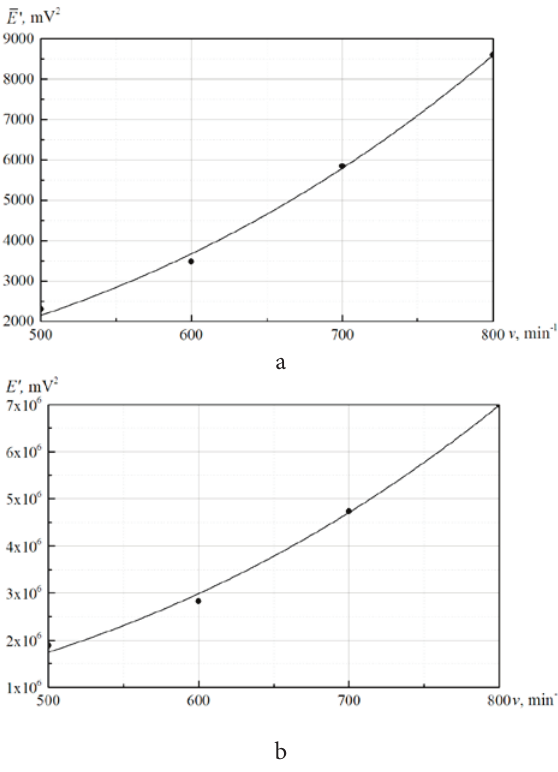
Fig. 6. Diagrams of accumulated average energy ' E ( a ) and accumulated total energy E' ( b ) of a resulting acoustic emission signal depending on the rotational speed of a friction pair v As the analysis of the data obtained shows, if speed v is equal to 500 min –1 , the values of the rates of accu- mulated average energy ' E and accumulated total en- ergy E' of acoustic emission signals that form will be taken as ' E = 2306.57 mV 2 and E' = 1.88 х 10 6 mV 2 . When value v is increased 1.2 times (to 600 min –1 ) the values ' E and E' increase, respectively, 1.505 and 1.498 times. This kind of increase can be observed simultan- eously with the further increase in the rotational speed of a friction pair. So, if speed v is equal to 700 min –1 , the values ' E and E' will increase, respectively, 2.534 and 2.51 times. When v is increased 1.6 times (to 800 min –1 ), the values ' E and E' will increase, respectively, 3.725 and 3.71